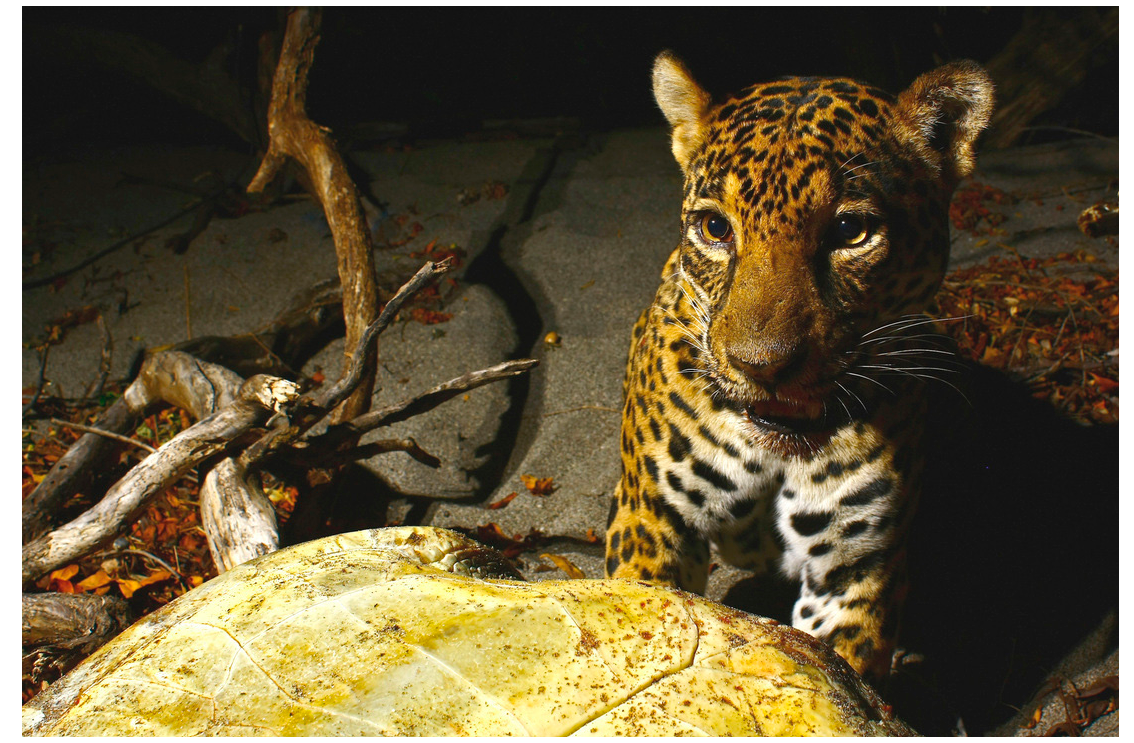
Figure 3. Documented olive ridley turtle ( L. olivacea ) kill by a jaguar ( Panthera onca ) at Santa Rosa National Park, Costa Rica (Photo by Alonso Sánchez from ACR Wildlife Photography, San José, Costa Rica 2022).